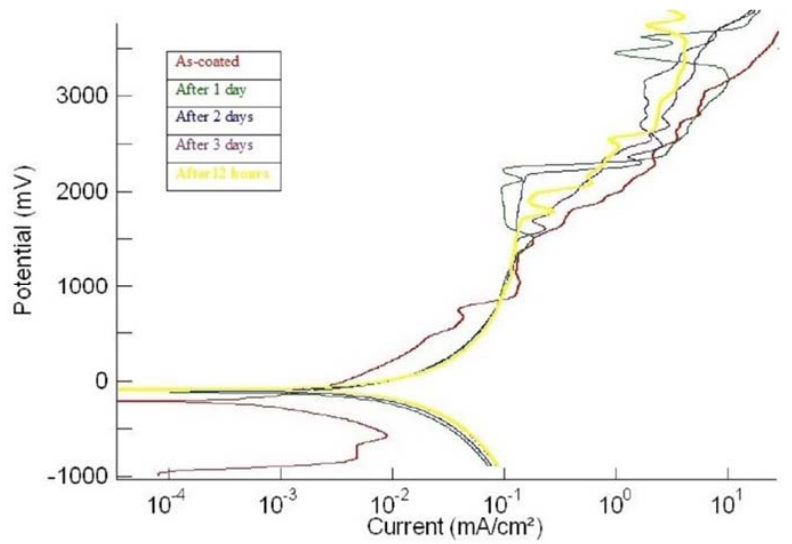
Figure 3. Polarization curves of ‘3ushcd’.